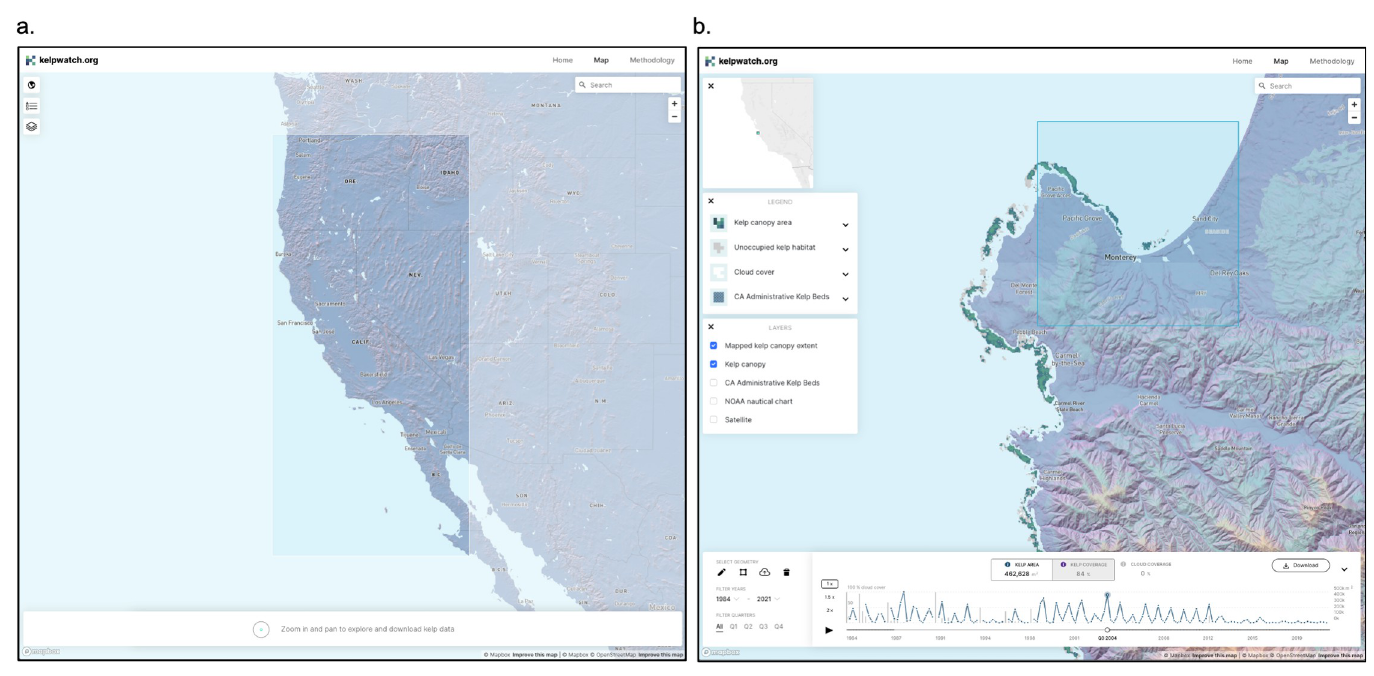
Fig 1. Kelpwatch web interface. a.) Visualization of map showing spatial extent of kelp canopy dynamics assessed here. b.) Zoomed in map view of the Monterey Peninsula showing kelp canopy area during the summer of 2004 in shades of blue to green. Unoccupied kelp habitat, or areas where kelp has been observed in the past but is not currently present, is shown in gray and areas obscured by cloud cover for the season (i.e., no data) are shown in white. The blue shaded box shows one of the 10 x 10 km cells used in this study and a seasonal (3-month) time series of kelp area within that cell is shown at the bottom (gray lines represent percent cloud cover of that region through time). Base map from OpenStreetMap and OpenStreetMap